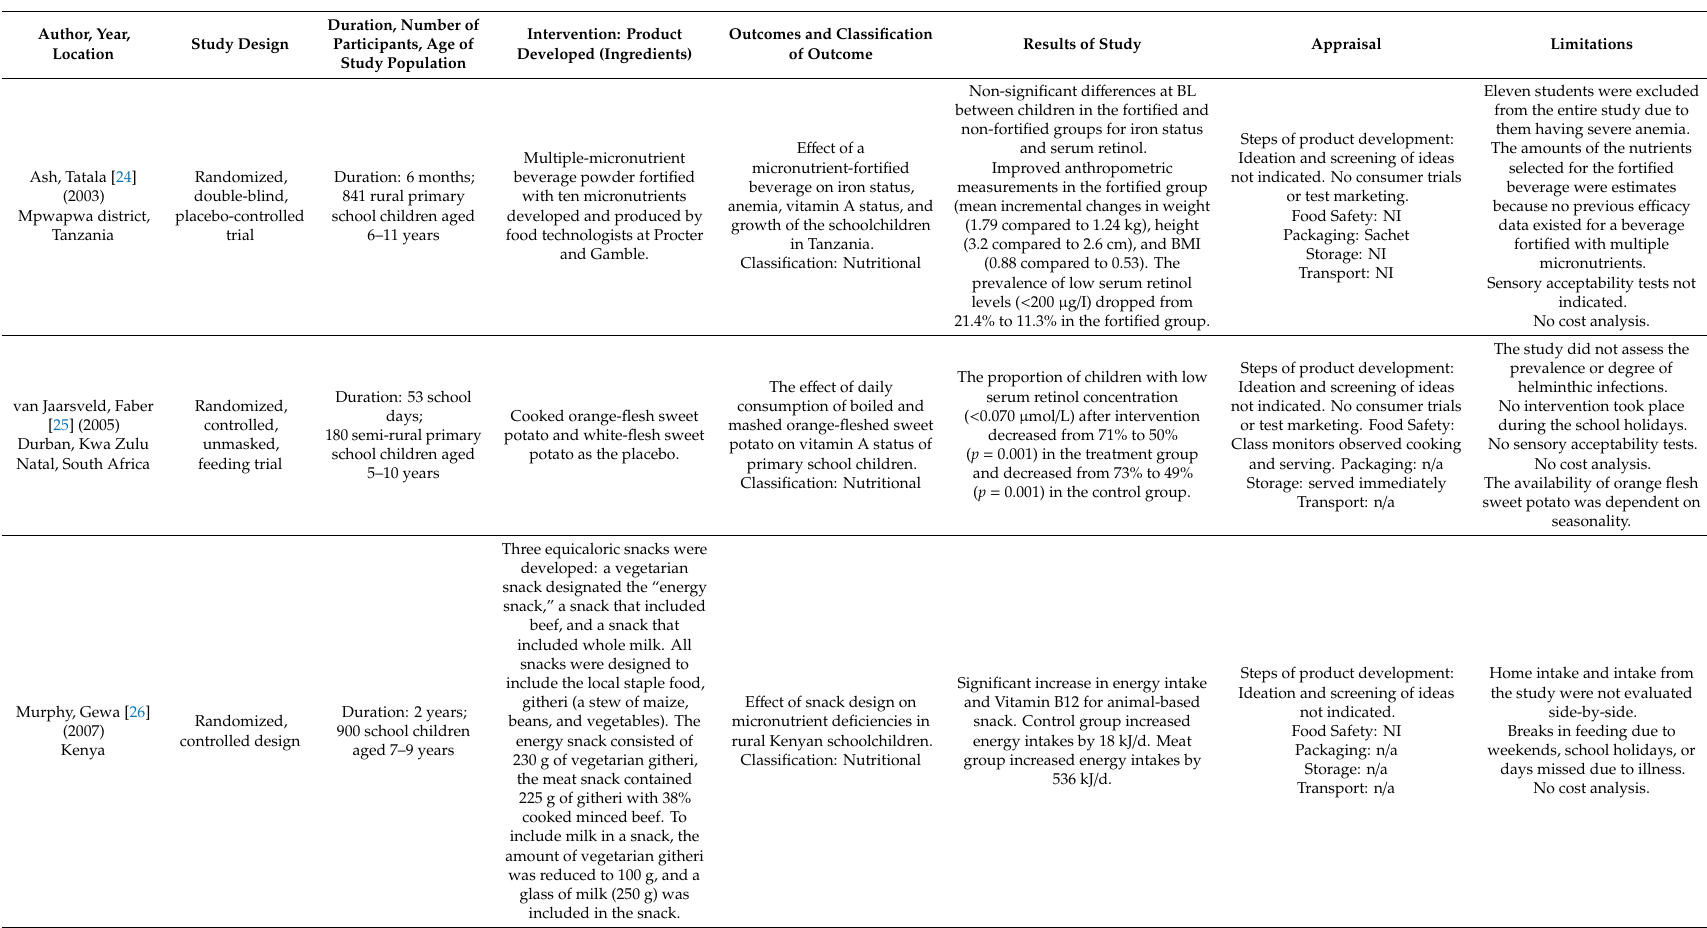
Table 1. Review of previous snack development